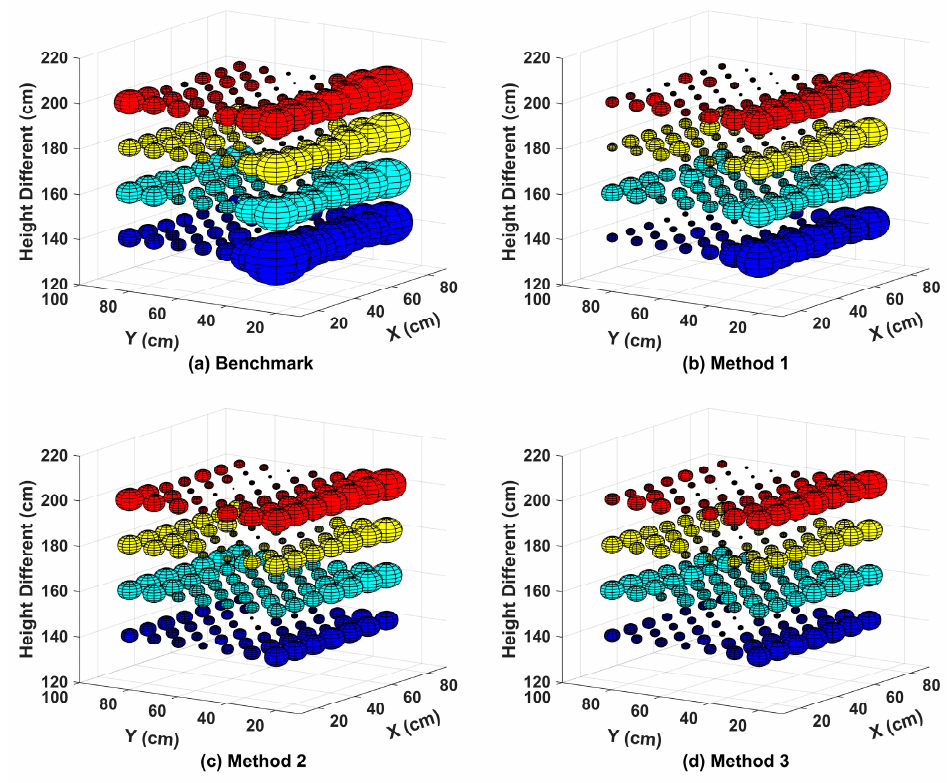
Figure 5. Spatial distribution of the 3D positioning error at different heights in the case of dis (1,2) = 40 cm for the ( a ) Benchmark, ( b ) Method 1, ( c ) Method 2, and ( d ) Method 3.